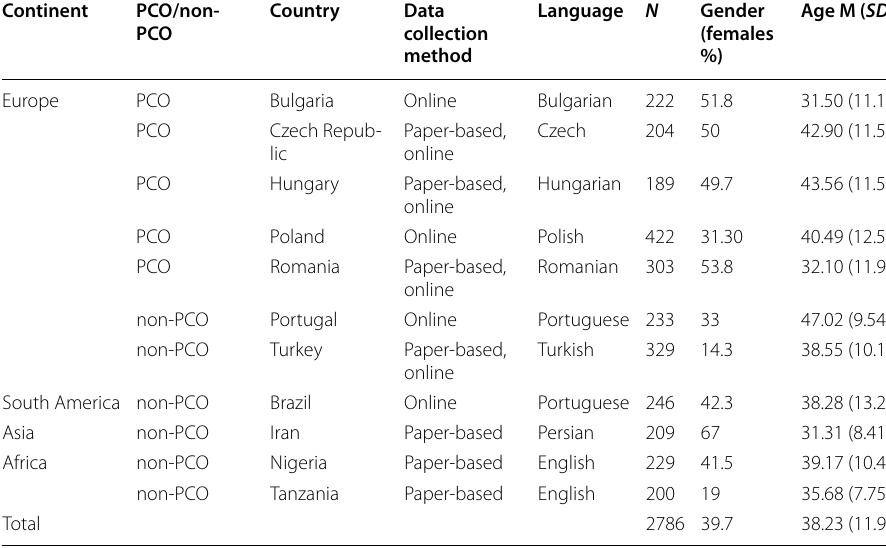
Continent PCO/non- PCO